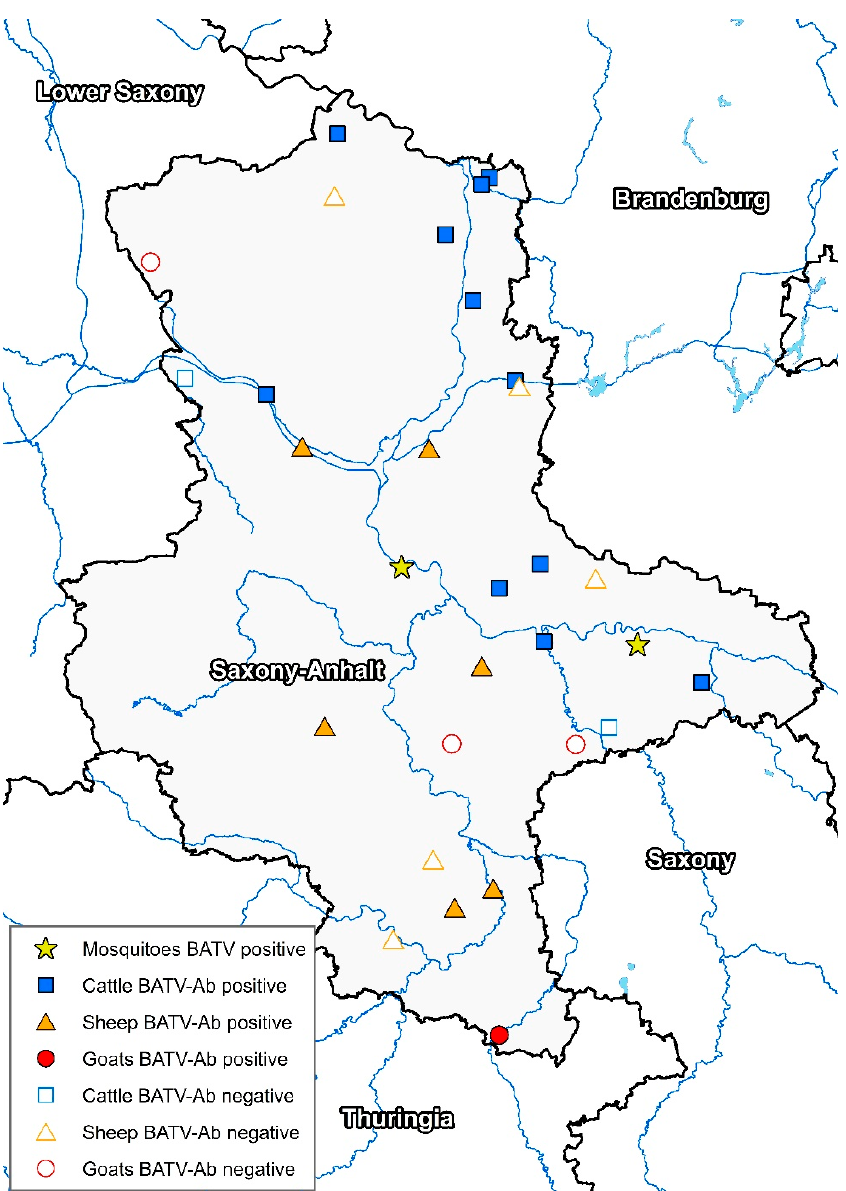
Figure 2. Geographical distribution of the investigated ruminant flocks in Saxony-Anhalt in combination with the serological results (BATV-Ab = BATV antibodies) and the sites with BATV-positive mosquitoes (virus or viral RNA).